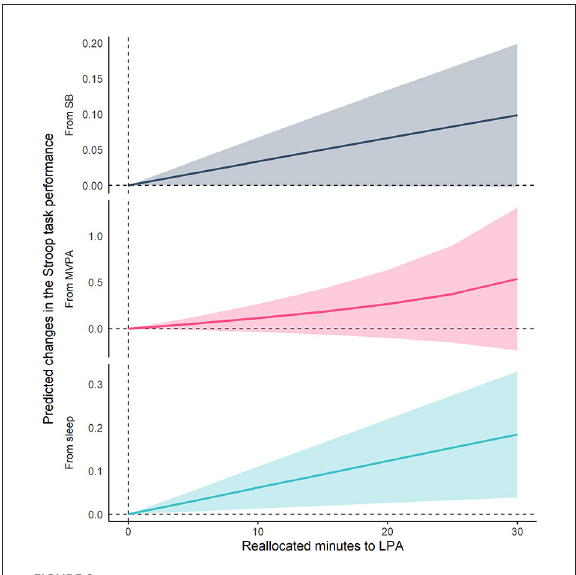
FIGURE3 Differences in predicted changes of Stroop task performance when fixed amounts of time were reallocated from one movement behavior to BLPA while keeping the remaining components constant at compositional means. The analysis was based on Model 2. SB, sedentary behavior; LPA, light-intensity physical activity; BLPA, bouted LPA; MVPA, moderate- to vigorous-intensity physical activity; BMVPA, bouted